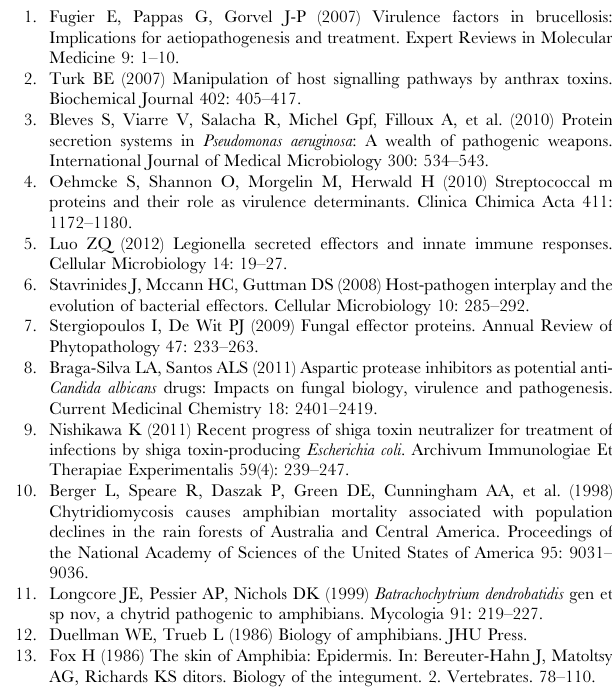
Table S1 Primers for four Bf adhesin loci. Primers do not all capture the complete predicted coding regions but do capture the region of length